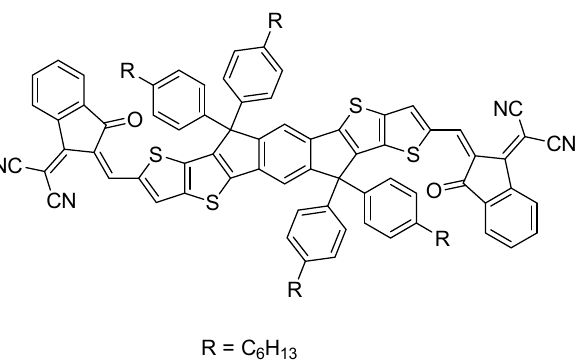
Figure 41. Structure of ITIC, the acceptor molecule utilized for the ternary PDot system [160].